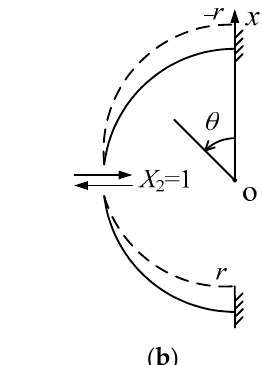
Figure 2. Basic system for internal force calculation of pressurized water conveyance tunnel.